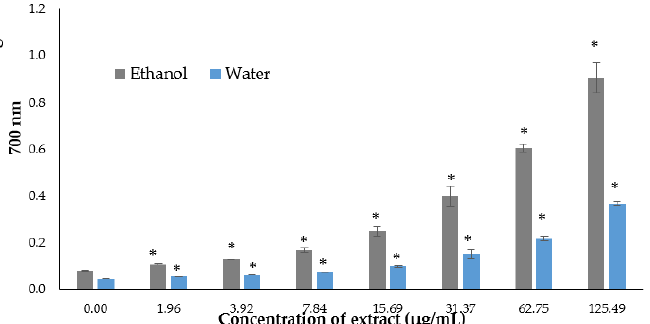
Figure 1. DPPH radical scavenging activity of the ethanol and water extracts of P. australis. Data are expressed as the mean ± SD ( n > 3). * p < 0.05 represents significant differences from the nega- tive control.